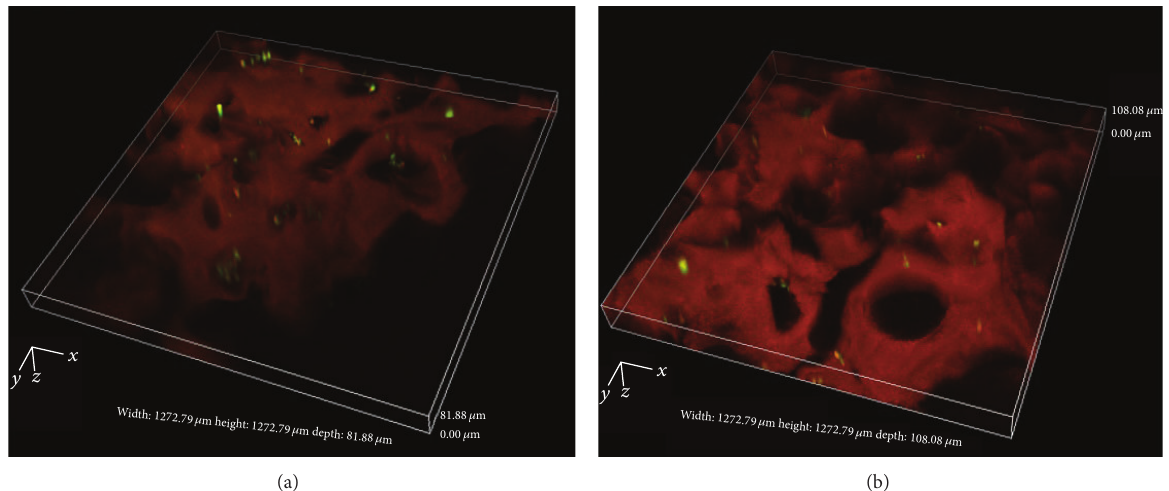
Figure 5: 3D laser scanning reconstruction of Live/Dead stained (a) hADSCs/G-A-PAA bioconstruct and (b) hADSCs/G-A bioconstruct. Viable (green) and dead (red) cells are seen embedded in the autofluorescent matrix (orange).